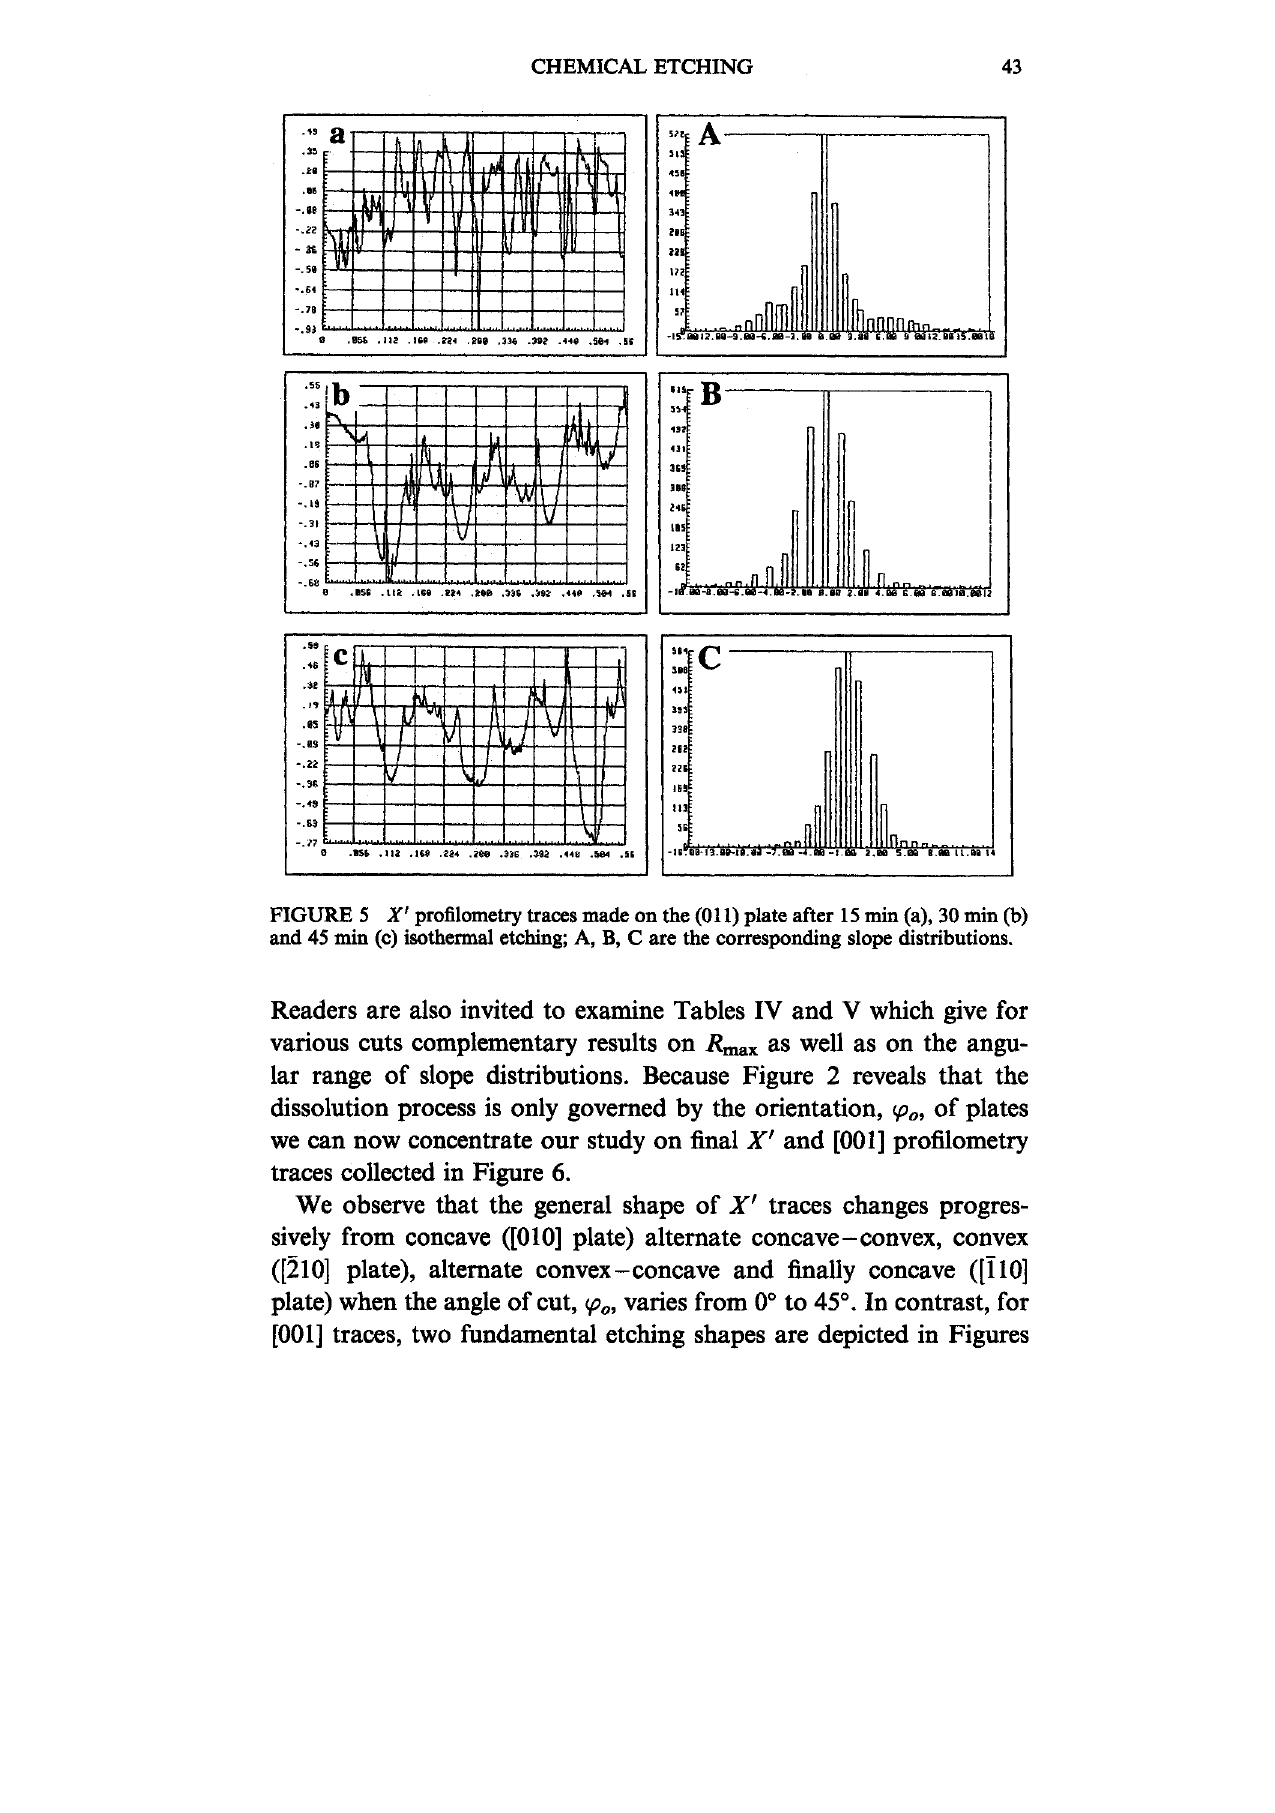
FIGURE 5 X’ profilometry traces made on the (011) plate after 15 min (a), 30 min (b) and 45 min (c) isothermal etching; A, B, C are the corresponding slope